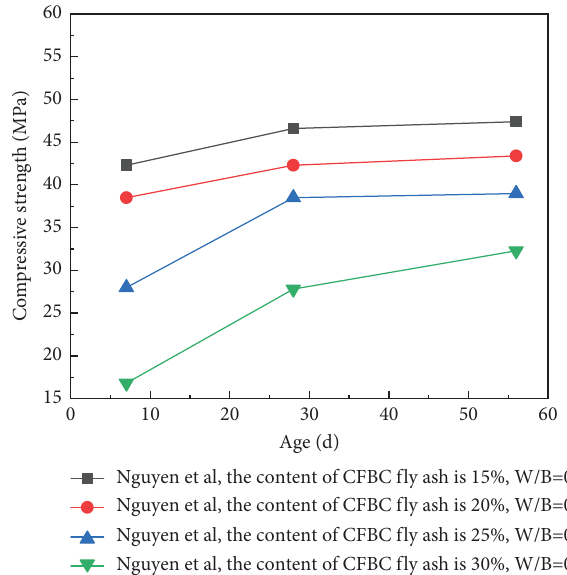
Figure 3: Efect of CFB fy ash content and age on the compressive strength of SCFC